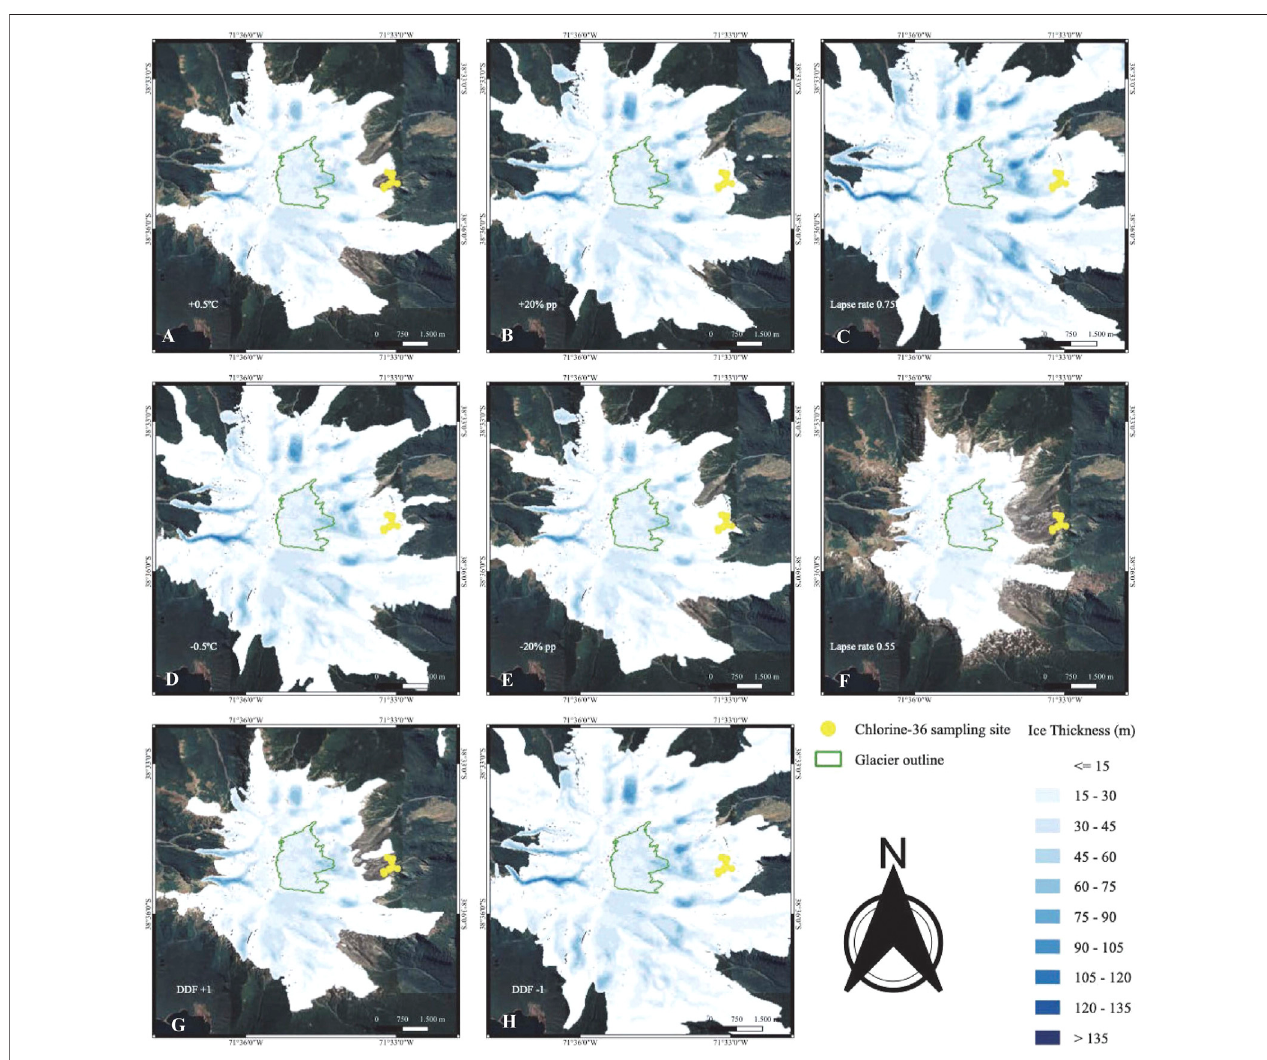
FIGURE 6 | Google Earth image of Monte Sierra Nevada with ice thickness results from the combined mass balance and fl ow models superimposed. The yellow circlesmarkthelocationsofdatedmoraine positionsfrom thisstudy, themodernglacialoutlineisrepresentedingreen. Fromtopleft tobottom middle. (A) Temperature increase of 0.5 ° C. (B) Precipitation increase of 20%. (C) Lapse rate of 0.75 ° C/100 m. (D) Temperature decrease of 0.5 ° C. (E) Precipitation decrease of 20%. (F) Lapse rate of 0.55 ° C/100 m. (G) DDF of +1. (H) DDF of -1.